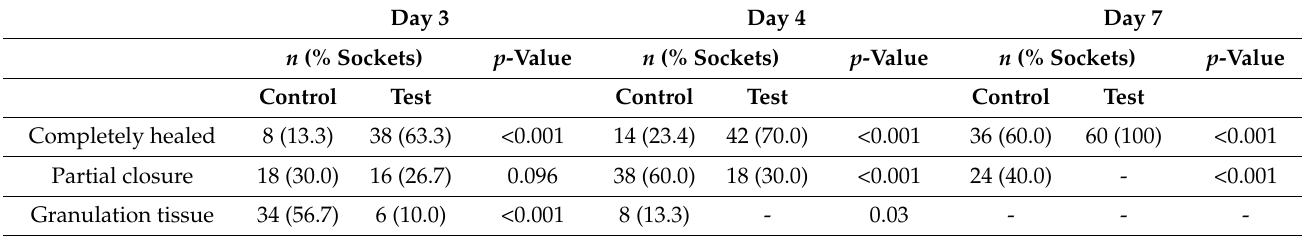
Table 1. Healing ratios and statistical significance of patients treated with control or propolis paste.